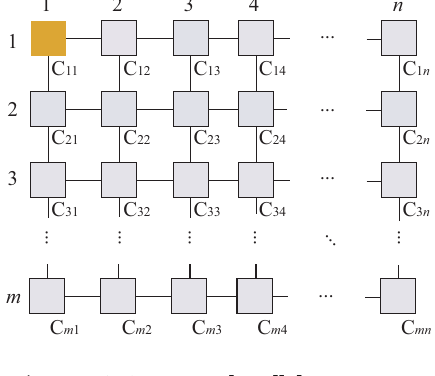
Fig. 1. A 2D rectangle cellular